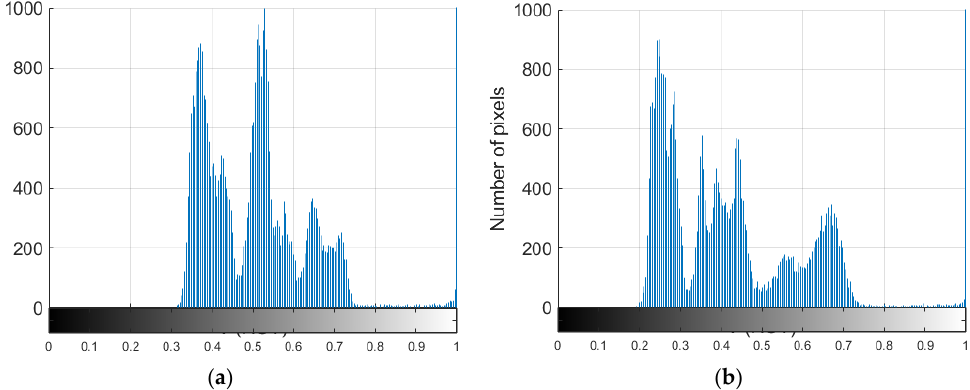
Figure 7. An example of image histograms of drapes. ( a ) Fabric drape without 3D printing; ( b ) fabric drape with 3D printed geometries.